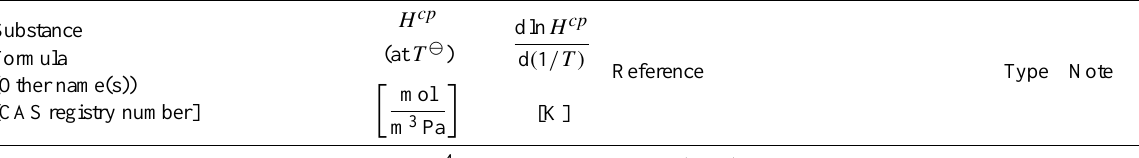
Table 6: Henry’s law constants for water as solvent